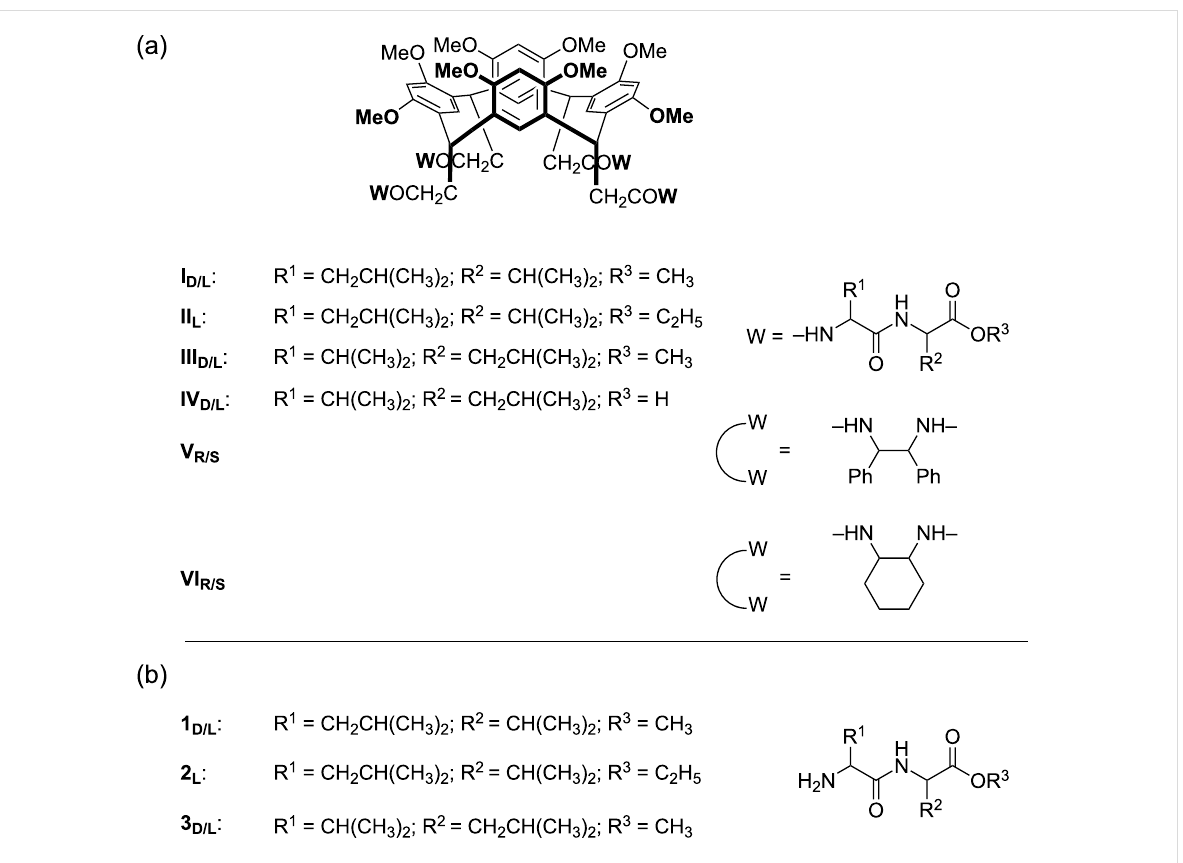
metry is due to the four axial pendants containing the chiral L-valine group. Two chiral effects were experimentally consid- ered: The configuration of the amine B and that of the guest G. According to theoretical calculations, the chiral effects are insignificant if the guest molecule in the [ Y S ∙ H ∙ G] + complex is located outside the cavity of the host, while a bimodal kinetic is mirrored by the coexistence of a different guest position depending on the G